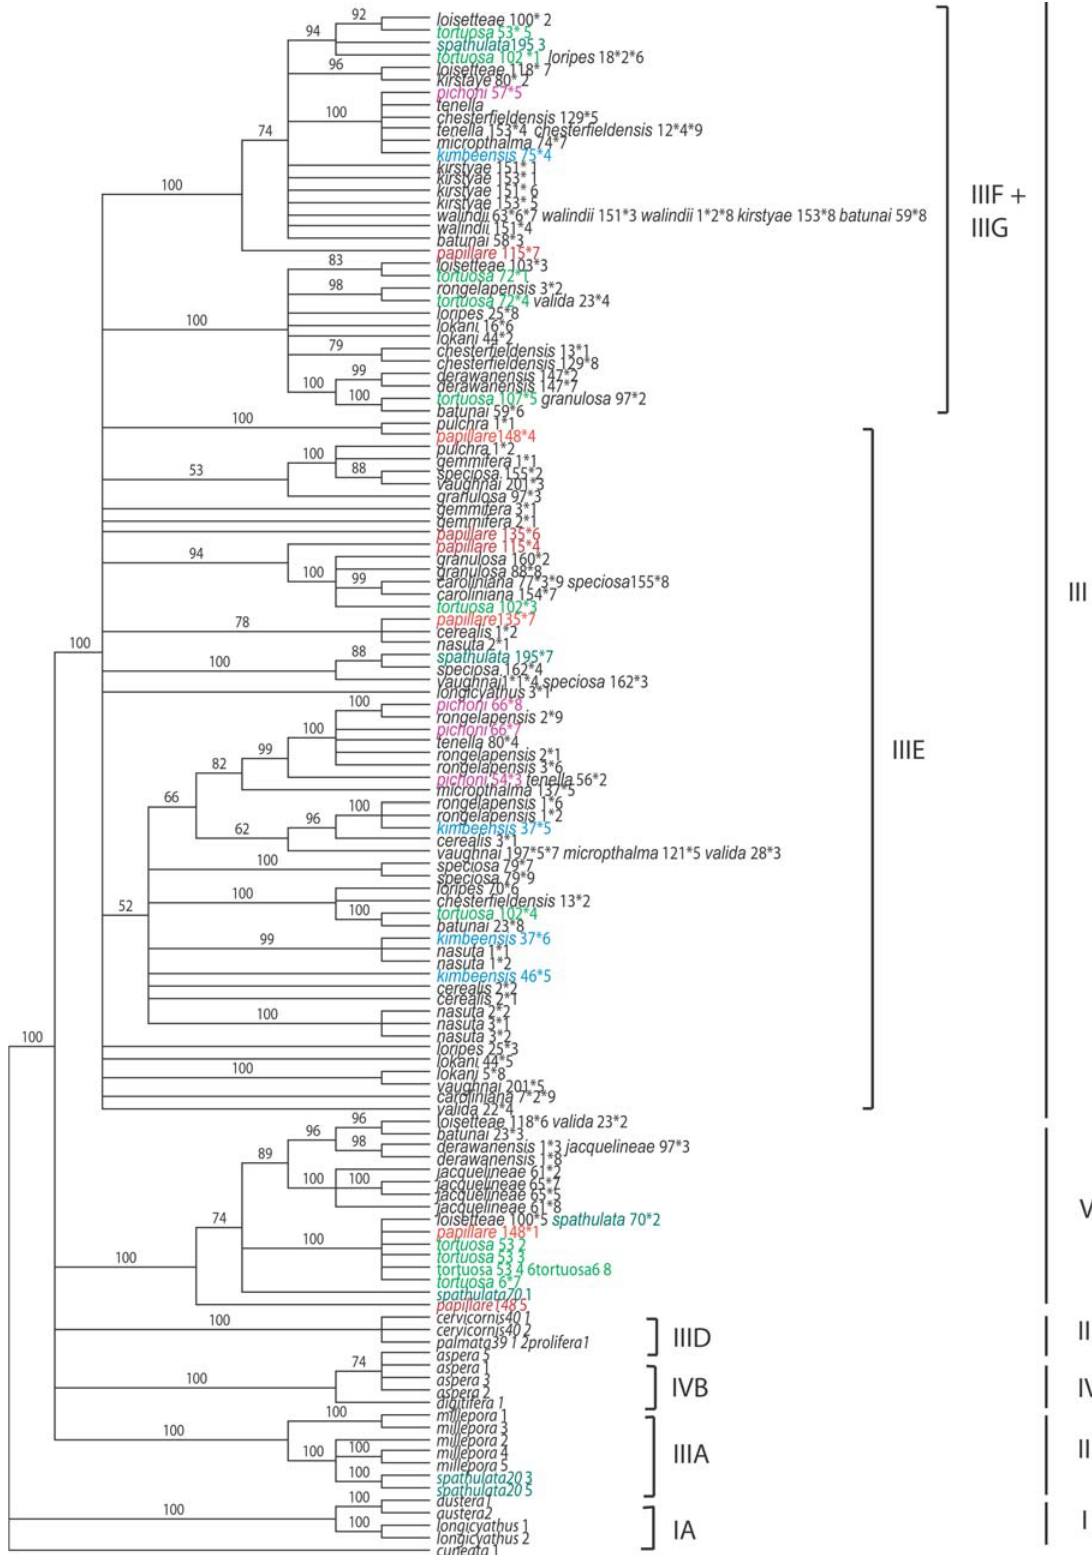
Figure 3. Phylogenetic analysis of PaxC data. The figure shows the majority rule ( . 50%) consensus tree obtained in a Bayesian analysis of nuclear sequence data for the thirty-five Acropora species included in this study, with Isopora cuneata defined as outgroup. Bayesian analyses used likelihood settings from best-fit model (HKY + G) selected by hLRT in MrModeltest 2.2 [12]: 5 million generations; burn in =50,000. Numbers above branches are posterior probability values supporting the topology shown and clades are labelled according to previous [5,9] analyses. Numbers after species names indicate the coral colonies from which the sequences were obtained; where more than one sequence was obtained per colony, the clone identity is given after an asterisk. Note that in some cases multiple clones (sometimes from different species) had identical sequences. doi:10.1371/journal.pone.0003240.g003 PLoS ONE | www.plosone.org